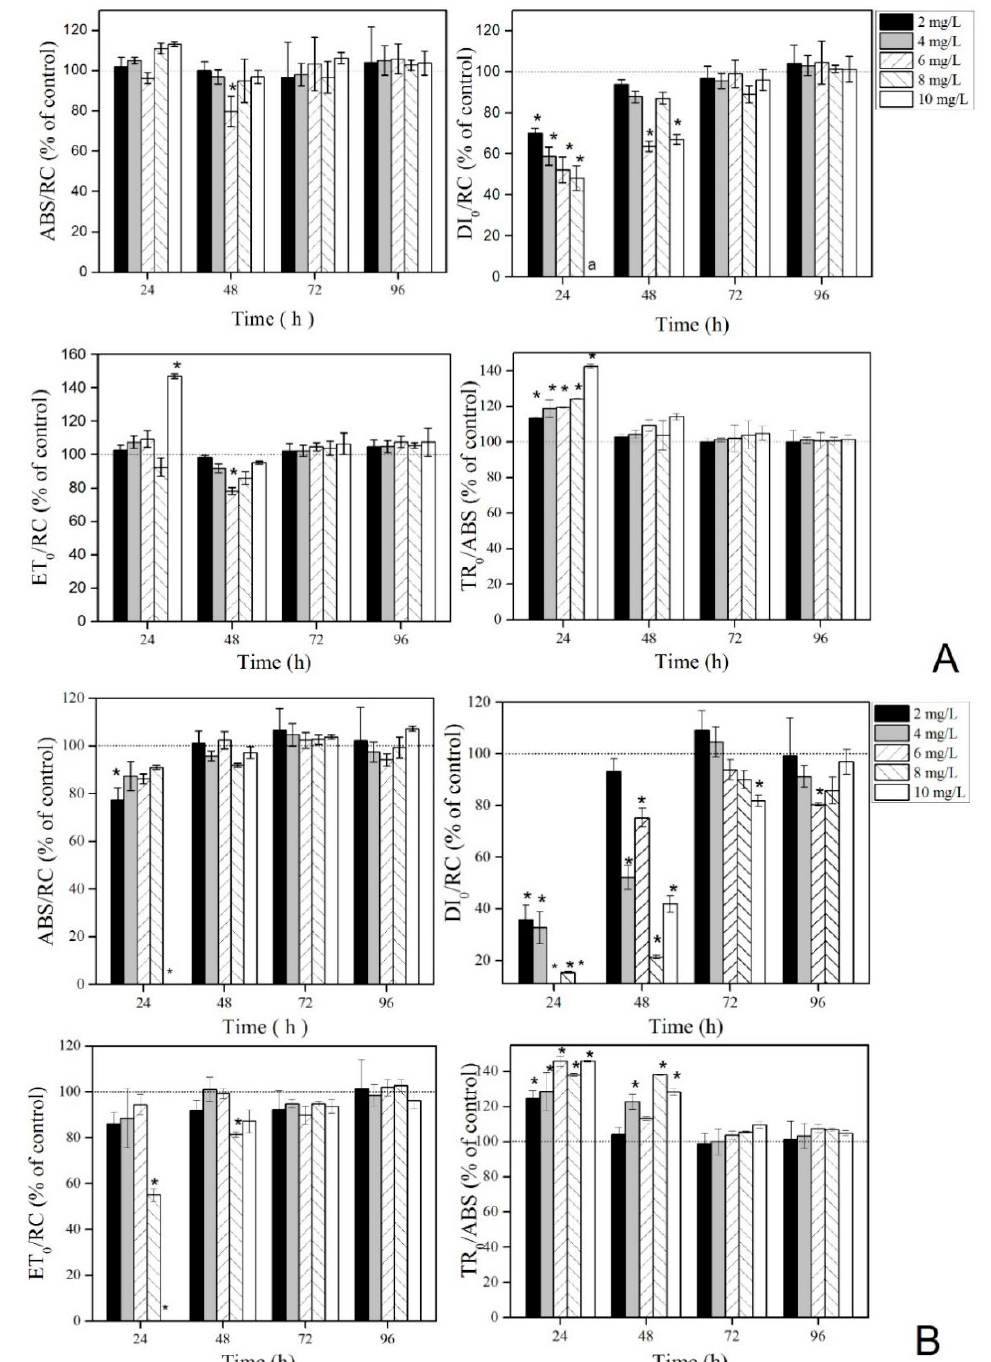
Figure 3. OJIP-test parameters expressed as a percentage of the control when C. vulgaris ( A ) and P. tricornutum ( B ) were treated with La(NO 3 ) 3 · 6H 2 O and dark-adapted for 15 min. * Significant difference compared with the control ( p < 0.05). a The value was too low to be measured.